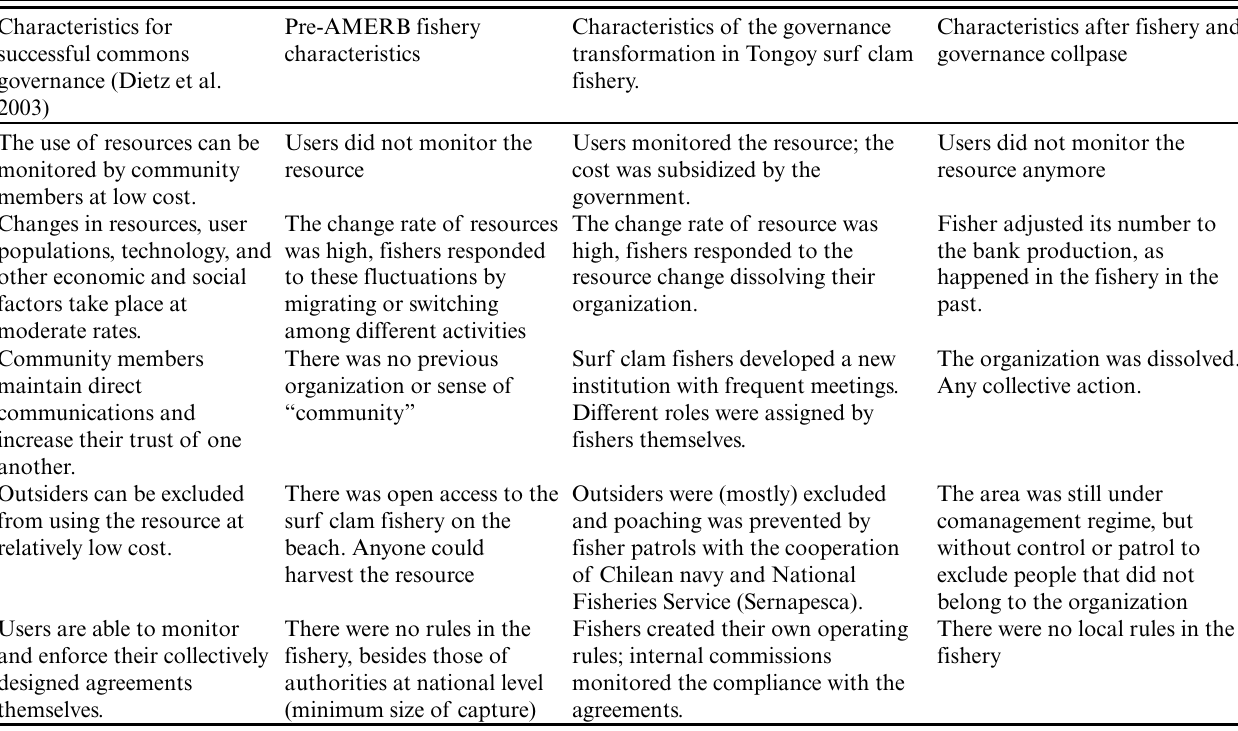
Table 1 . Characteristics of successful commons governance (sensu Dietz et al. 2003) and the fishery characteristics observed in the pre- AMERB (Management Areas for the Exploitation of Benthic Resources) fishery and the governance transformation after AMERB